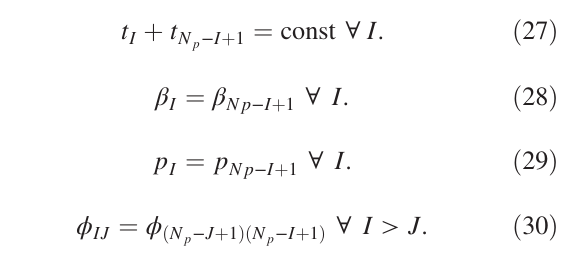
FIG. 22. Scaling of the min ½ I with different ω λ . Parameters: ct ð R=Q Þ ¼ 10 4 Ω , t λ